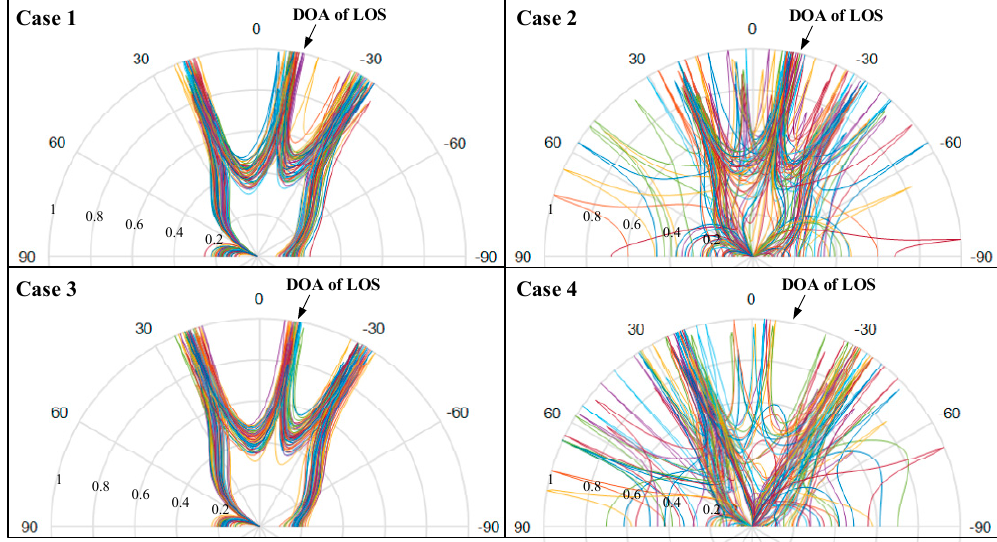
Figure 7. Azimuth spectrum synthesis of multiple continuous snapshot packets.